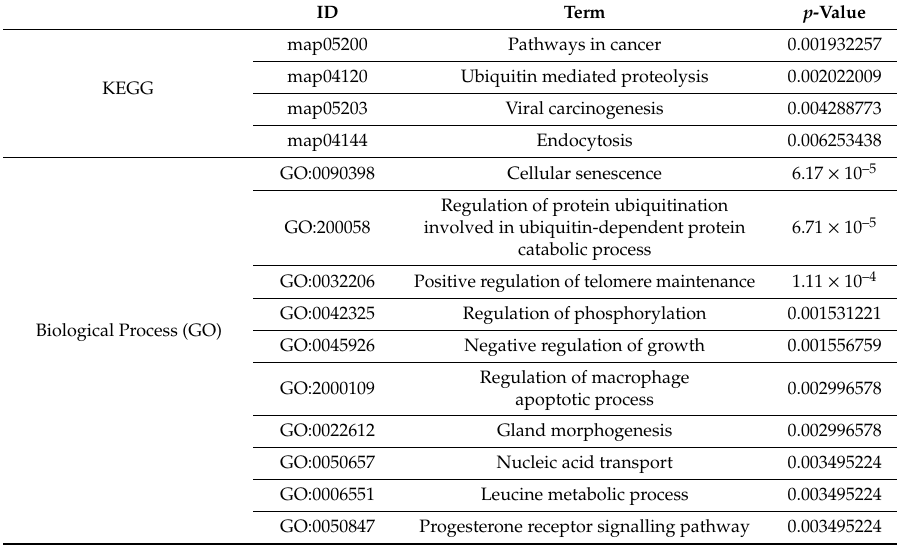
Table 5. Functional enrichment analysis of DEGs. Kyoto Gene and Genome Encyclopaedia (KEGG) pathways and GO terms were identified using Enrichr ( p < 0.01). The list of biological process GO terms were condensed into a smaller representative list using REVIGO (similarity < 0.5) and the top 10 biological process GO terms, according to p -value, are